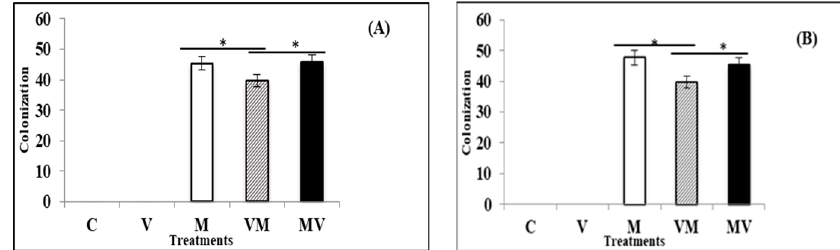
Figure 5. Average percentage of colonization in the plants infected by TBSV ( A ) and ToMV ( B ). Uninfected control plants without AM fungi (C), uninfected control plants with AM fungi (M), TBSV / ToMV -infected plants without AM fungi (V), TBSV / ToMV -infected plants before mycorrhiza (VM) inoculation and inoculated plants with mycorrhiza before TBSV / ToMV infection (MV). Significant di ff erence between colonization of treatments is shown by (*) [using oneway ANOVA and Bonferroni post-hoc test ( p < 0.001)]. For each treatment, three replicates were tested. Error bars represent SD.